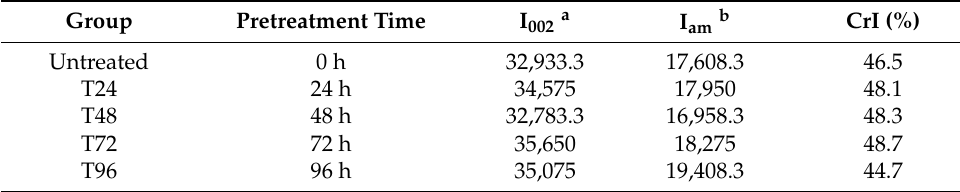
Table 1. CrI at different pretreatment